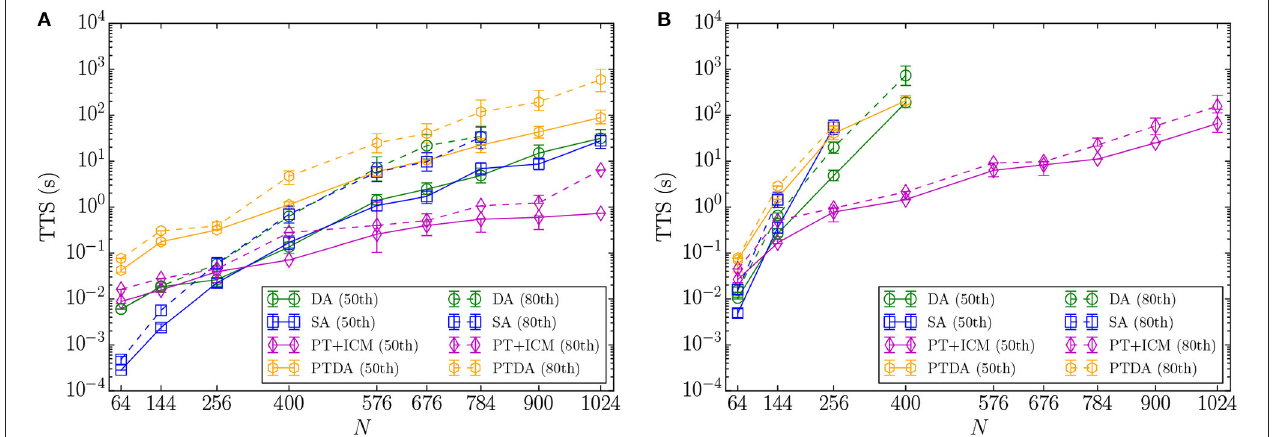
FIGURE 3 | Mean, 5th, and 95th percentiles of the TTS distributions (TTS 50 and TTS 80 ) for (A) 2D-bimodal and (B) 2D-Gaussian spin-glass problems. For some problem sizes N , the percentiles are smaller than the symbols.